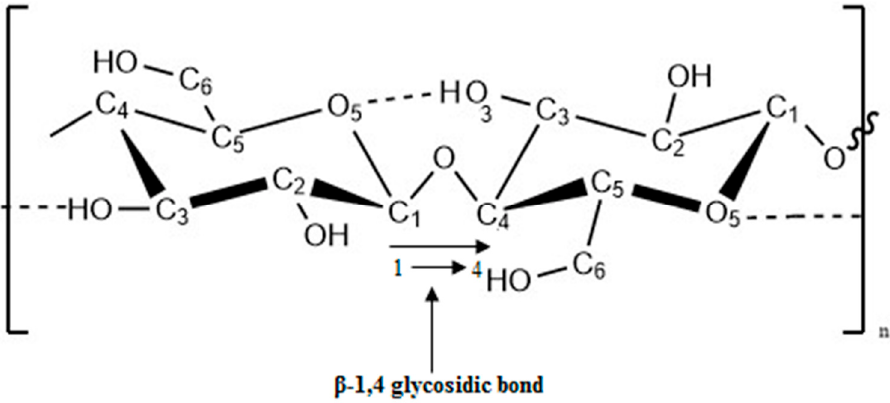
Figure 3. β -1,4 glycosidic bond of a cellulose unit.